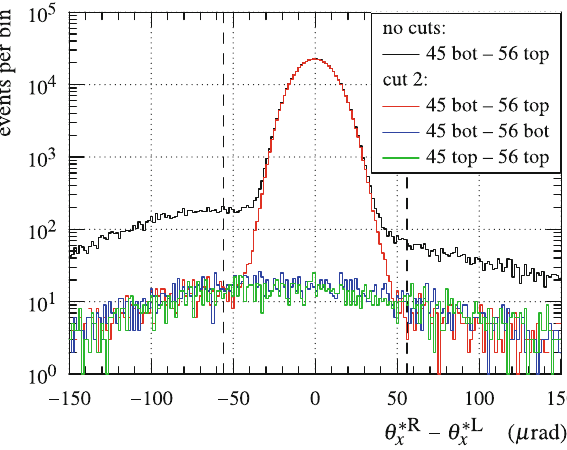
Fig. 5 Distributions of discriminator 1, i.e. the difference between the horizontalscatteringanglereconstructedfrom theright andtheleftarm. Data from LHC fill 5314. Black and red curves: data from diagonal 45 bottom–56top,thedifferentcolourscorrespondtovariouscombinations of the selection cuts (see numbering in Table 2). Blue and green curves: data from anti-diagonal RP configurations, obtained by inverting track y coordinate in the left arm. The vertical dashed lines represent the boundaries of the signal region ( ± 4 σ )